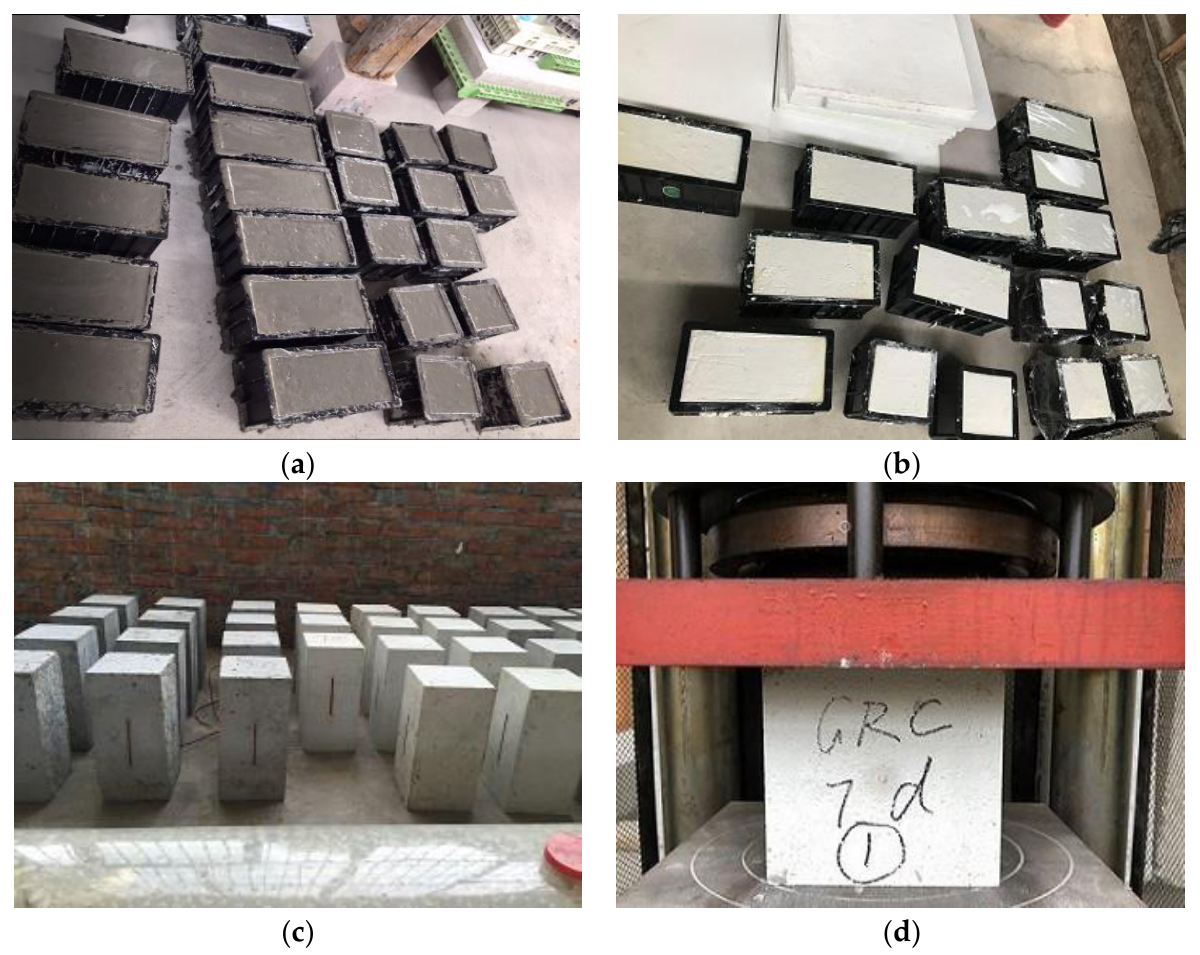
Figure 4. Experimental process of mechanical properties of materials: ( a ) Manufacture of concrete test block; ( b ) manufacture of GRC test block; ( c ) grouping and pasting of test blocks; ( d ) loading of test block.